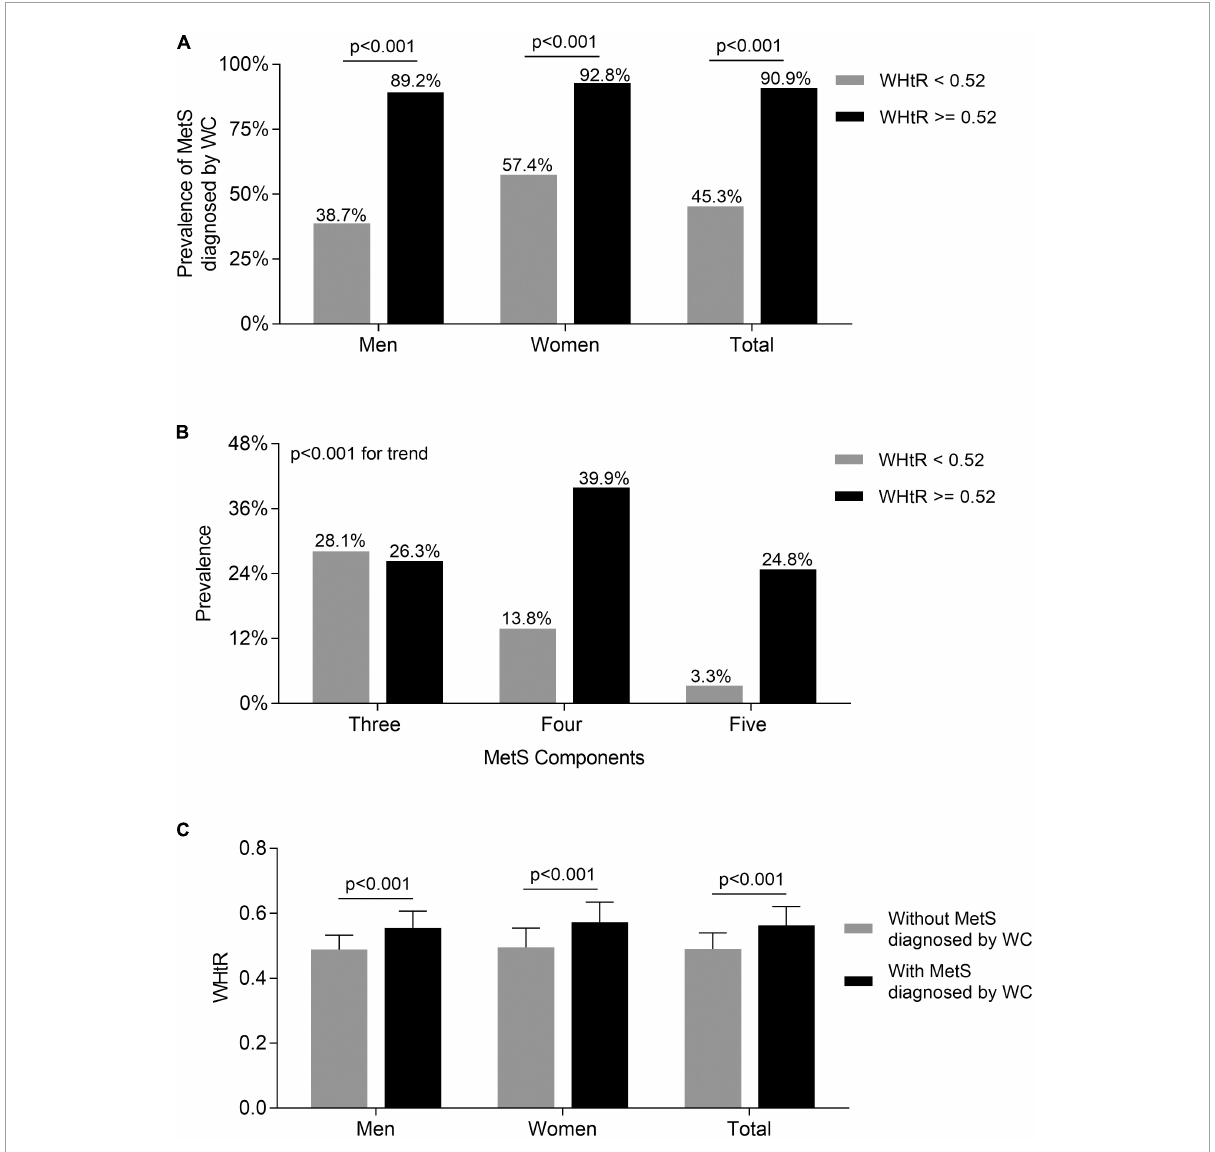
FIGURE3 Comparisons of the prevalence of MetS diagnosed by WC between the subjects with WHtR < 0.52 and ≥ 0.52. (A) Comparison of the prevalence of MetS diagnosed by WC stratified by sex between the subjects WHtR < 0.52 and ≥ 0.52 after adjusting for age and DD. (B) Comparison of the number of MetS components between the subjects with WHtR < 0.52 and ≥ 0.52. (C) Comparison of the values of WHtR stratified by sex between the subjects with and without MetS diagnosed by WC after adjusting for age and DD.